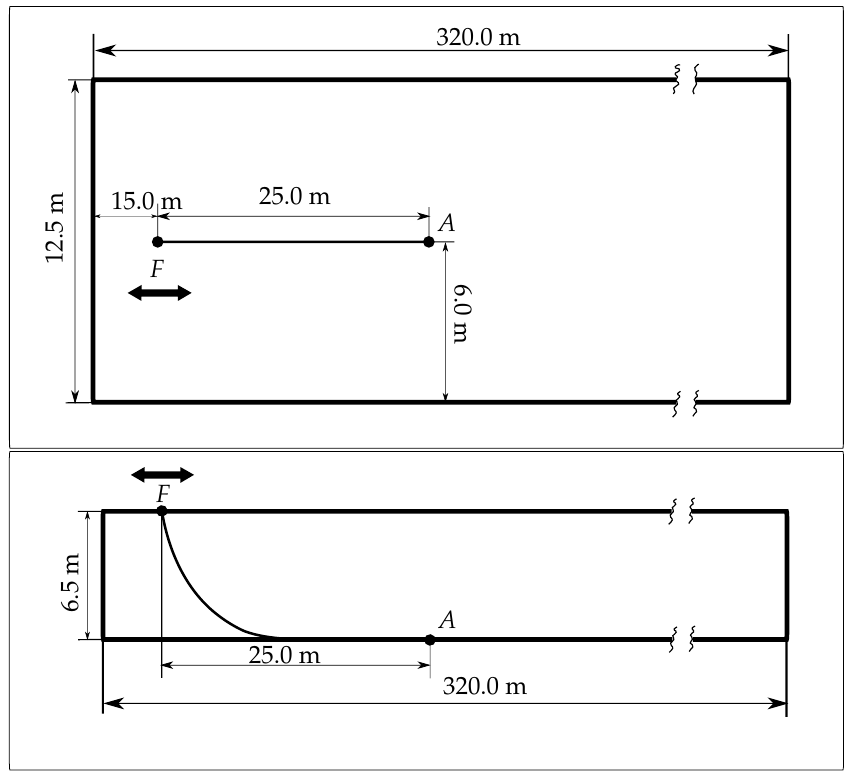
Figure 6. Schematic layout of the top and side views of the experimental